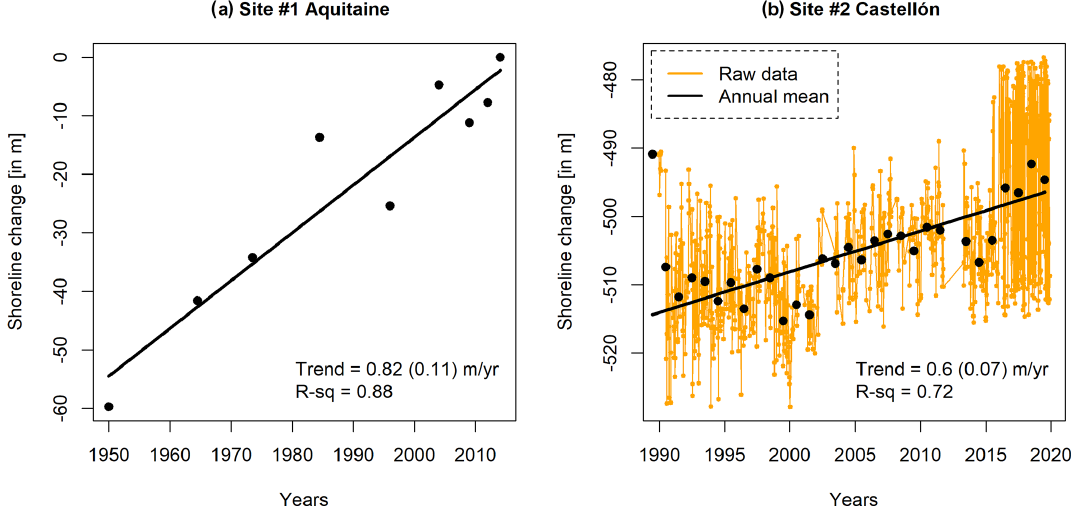
Figure 4. Observed shoreline change evolution in (a) site no. 1 in Aquitaine and (b) site no. 2 in Castellón. In Castellón, 859 available observations (orange line) and annual averages (black dots) are shown. The black line shows the linear trends calculated from the annual averages, and their standard error is written in brackets. Note that, by convention, positive trend values indicate shoreline